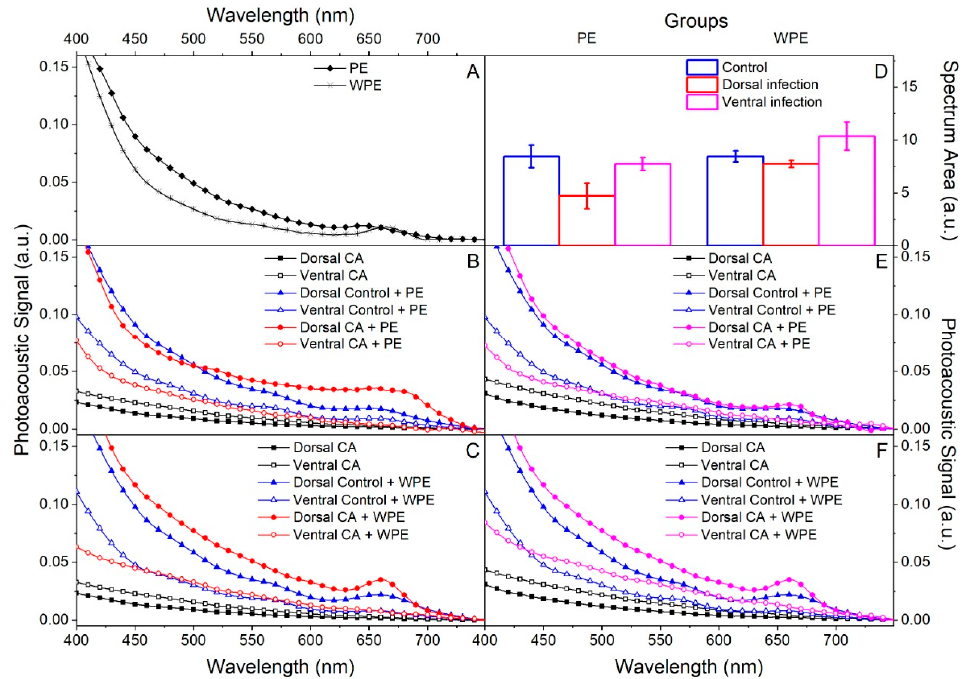
Figure 5. Evaluation of PE and WPE permeation of human nails by photoacoustic spectroscopy (PAS). Nails were infected for 7 days with C. albicans on the dorsal ( B and C ) and ventral ( E and F ) surfaces, then PE and WPE were applied once to the dorsal surface and the nails were incubated for 24 h. Readings obtained from the dorsal (filled markers) and ventral (empty markers) surfaces. ( A ) Readings of extracts alone. ( B and C ) Treatment with PE and WPE, respectively in non-infected nails (control—blue lines) and infected ones (red lines). Readings made in infected nails without extract (black lines). ( D ) Integration of the area under the curve of the ventral spectra to quantify permeation. ( E and F ) Treatment with PE and WPE, respectively, in non-infected nails (control—blue lines) and infected ones (pink lines). Readings made in infected nails without extract (black lines).